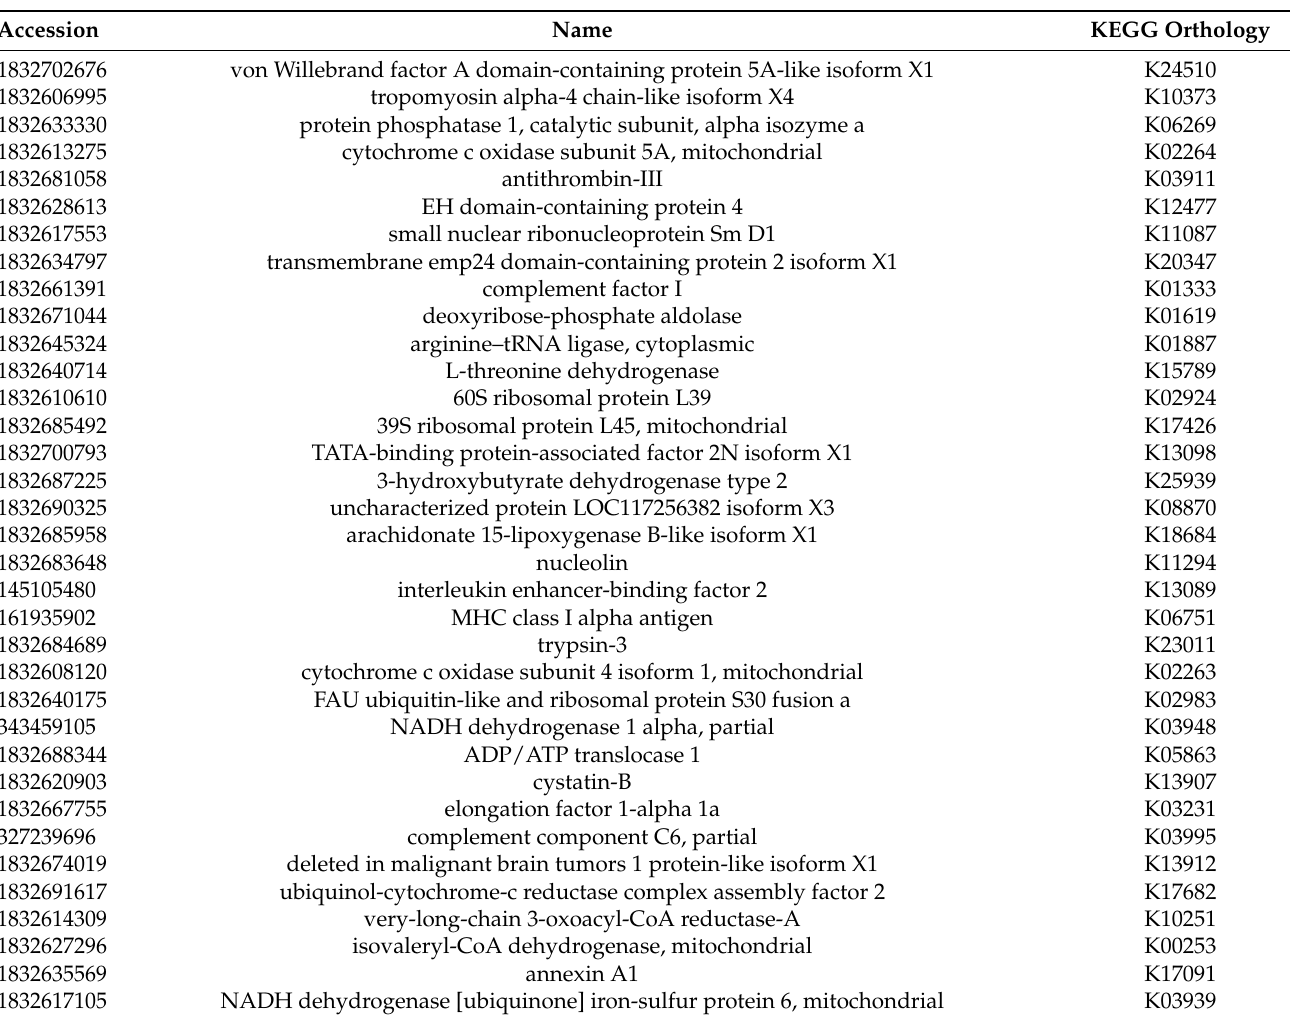
Table A2. Differentially expressed proteins pathways annotated in KEGG Automatic Annotation